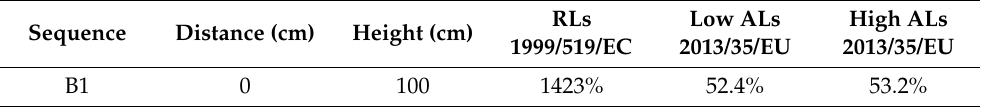
Table 7. Measurements results with the ELT-400 probe (Postprocessing of the data acquired from the analogue outputs—Mode Field Strength 320 µT—Range Low—Low Cut 30 Hz).